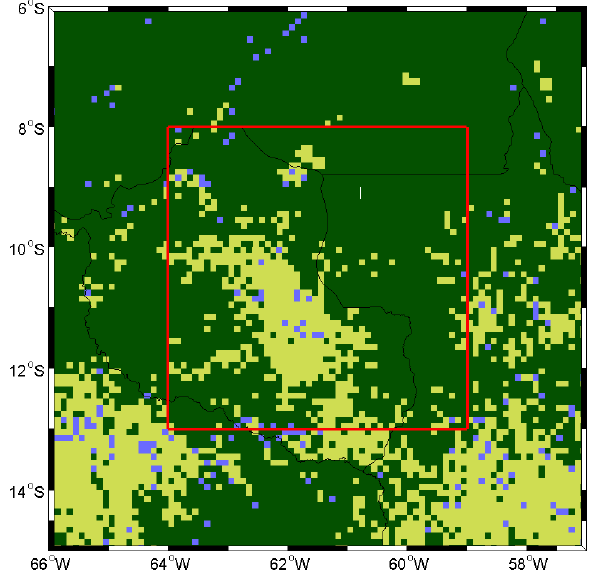
Fig. 1. Land cover classifications for the year 2004. Dark green pixels represent evergreen forests and light green pixels represent deforested land (pasture). Blue pixels represent land classifications that are not included in either of these two categories. The 5 ◦ × 5 ◦ study region is outlined with a red box. On average between 2004 and 2007, roughly 73% of our study region is classified as forested land and 25% of our study region is classified as deforested